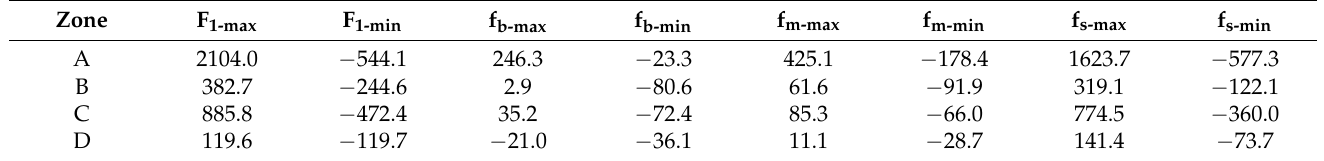
Table 1. The maxima and the minima of F l , f b, f m , and f s in the four regions A, B, C, and D (unit: